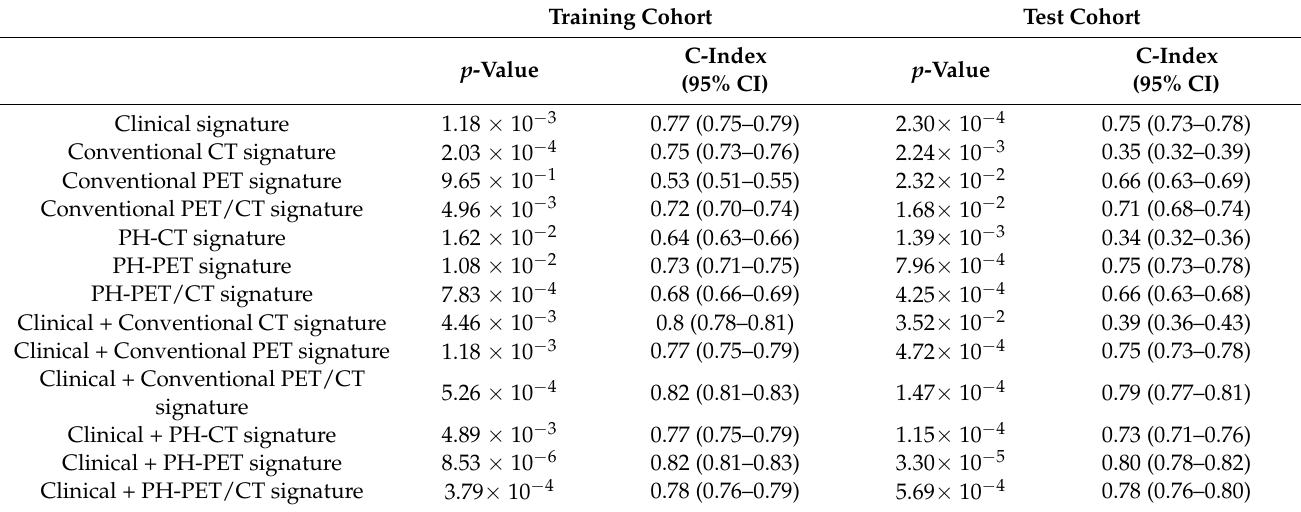
Table 3. Summary of p -values and C indices from the 13 types of signatures in this